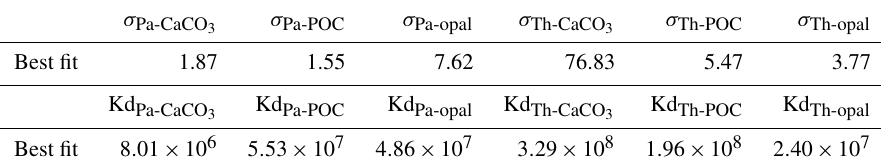
Table 2. Best fit σ i,j values and corresponding Kd